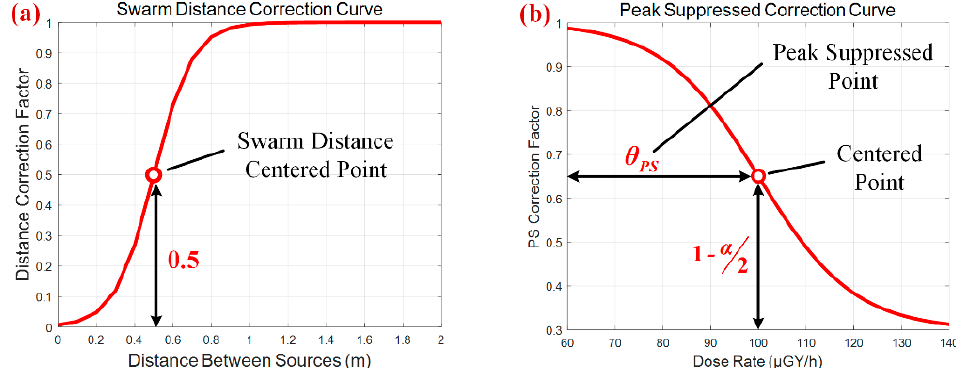
Figure 4. The particle weight correction curves. ( a ) The swarm distance correction curve. ( b ) The peak suppressed correction curve.